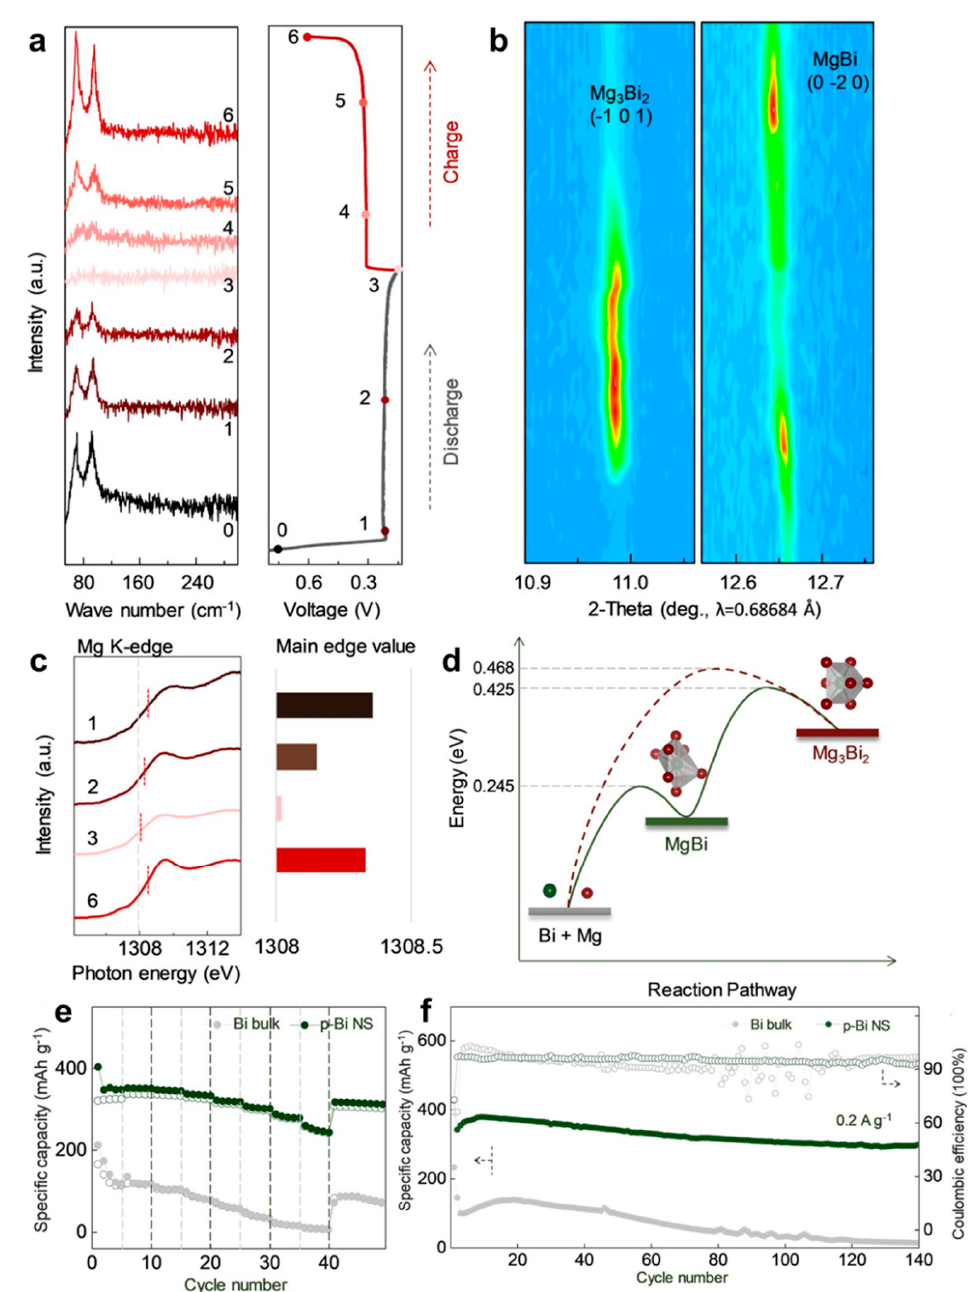
Figure 9. ( a ) The ex situ Raman spectra of p-Bi NS in the initial cycle and the corresponding discharge/charge profile. ( b ) Contour maps of synchrotron-based operando XRD analyses in the initial cycle. ( c ) Normalized Mg K-edge NEXAFS spectra. ( d ) Illustration of computed energy barrier in different reaction pathways with or without an intermediate state. ( e ) Rate performance and ( f ) cycling stability of the Bi bulk and p-Bi NS electrodes. Reproduced with permission [43]. Copyright 2020, Wiley-VCH Verlag GmbH & Co.